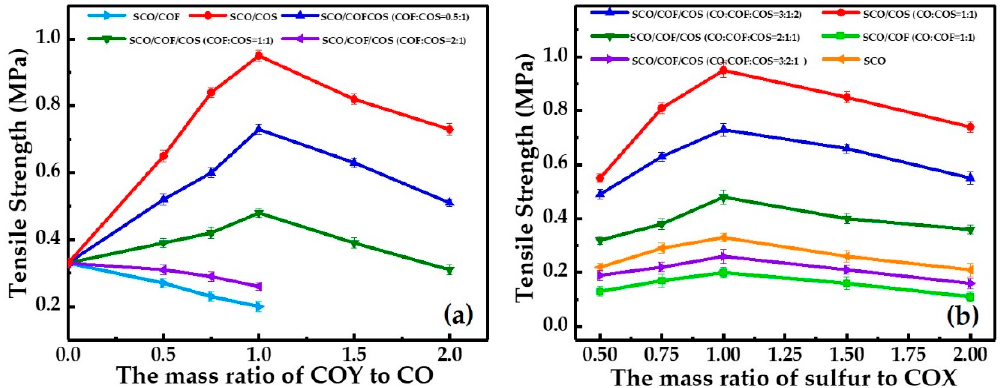
Figure 5. Tensile strength of the prepared samples. ( a ) Tensile strength variation in samples versus the mass ratio of COY to CO (m S / m COX = 1); ( b ) tensile strength variation in samples versus the mass ratio of sulfur to COX.